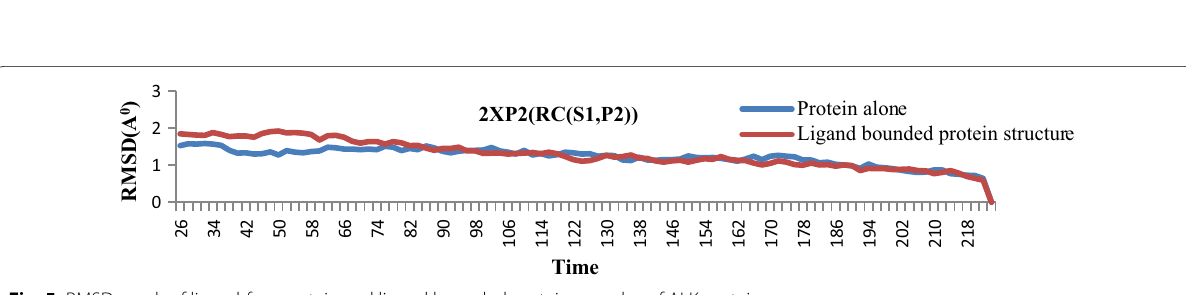
Fig. 5 RMSD graph of ligand-free protein and ligand bounded protein complex of ALK